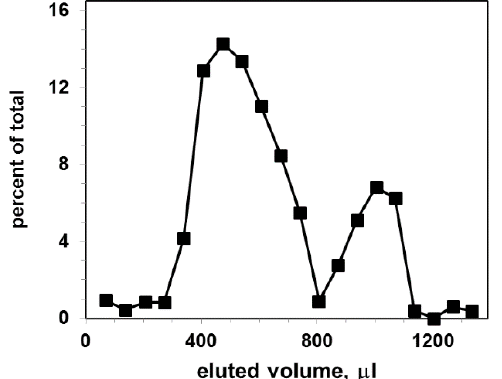
Figure 3. Gel filtration elution profile for exosomal liposomes (concentration 9 × 10 9 particles per mL) after incubation with CTB555: vertical axis, percent of total fluorescence; horizontal axis, eluted volume. The excitation and emission wavelengths of the fluorescence were λ ex / λ em = 545/565 nm.